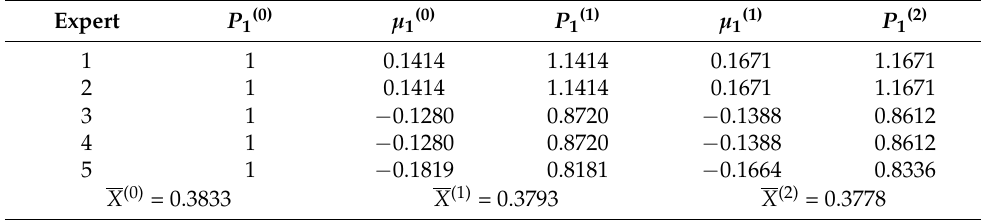
Table 6. Correction of tunnel design score.